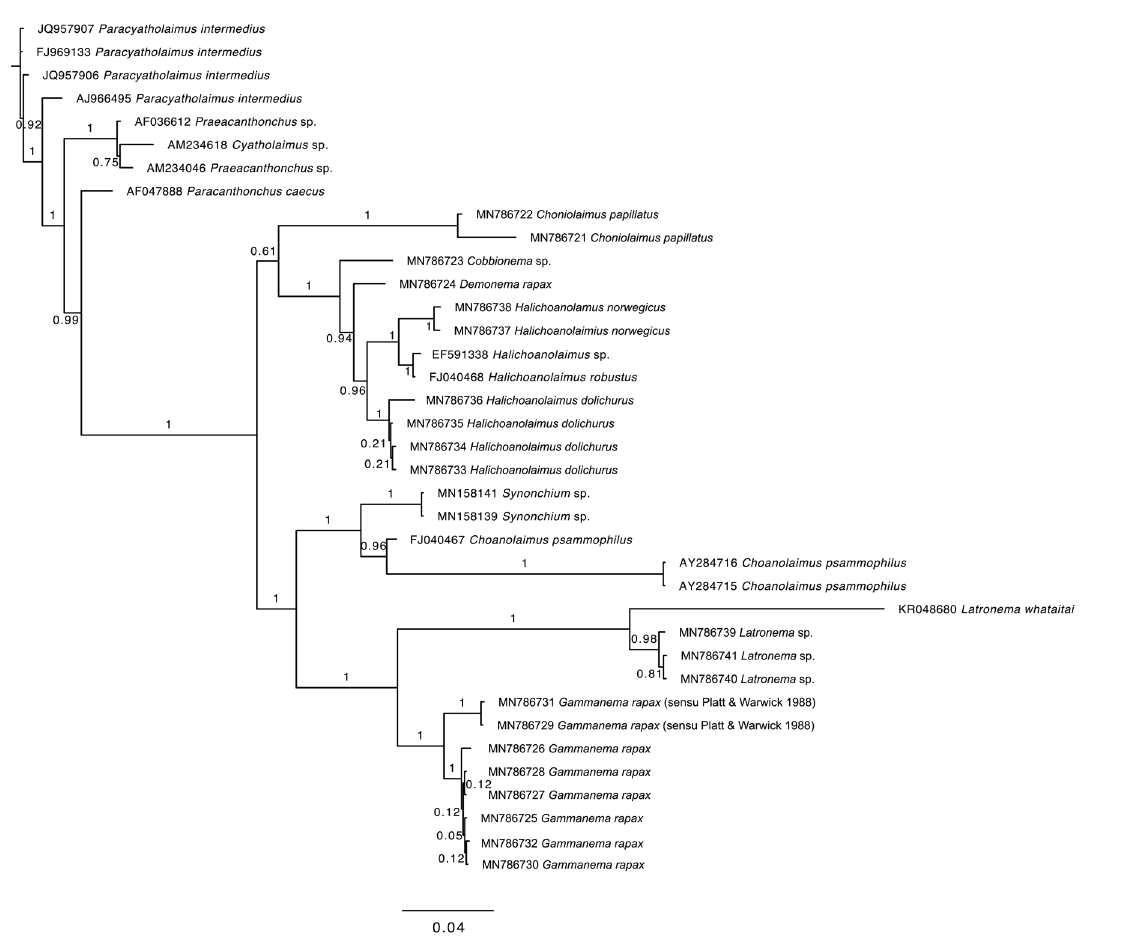
Fig. 11. Bayesian phylogenetic tree of Selachinematidae Cobb, 1915 inferred from 18S rRNA data, using alignments based on secondary structure models using REV GAMMA for unpaired sites and RNA16A for paired